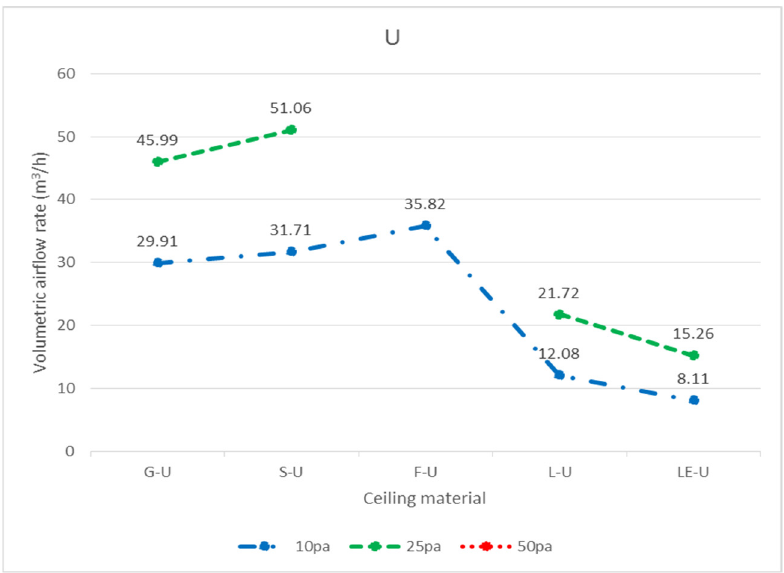
Figure 16. The unit leakage volume (m 3 /(h.m.)) of each specimen under each pressure difference with airflow from bottom to top (U).